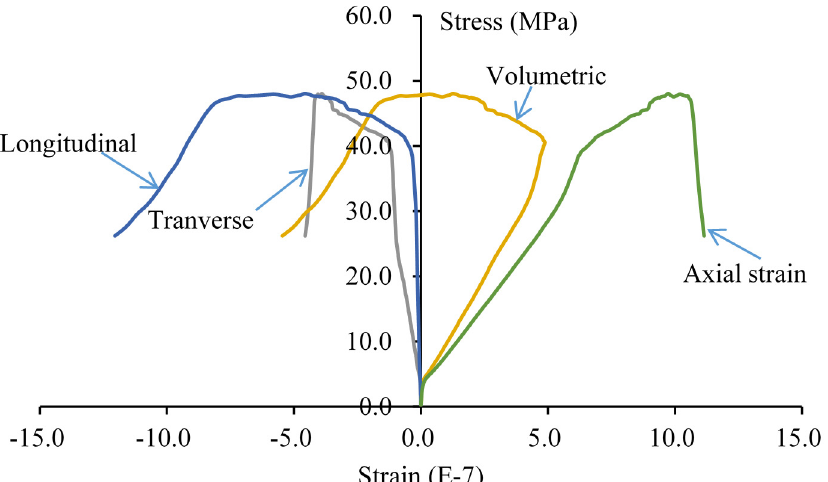
Figure 12. The complete stress-strain curve of the double-fissured specimen under uniaxial compression under fissure water pressure (7%  α